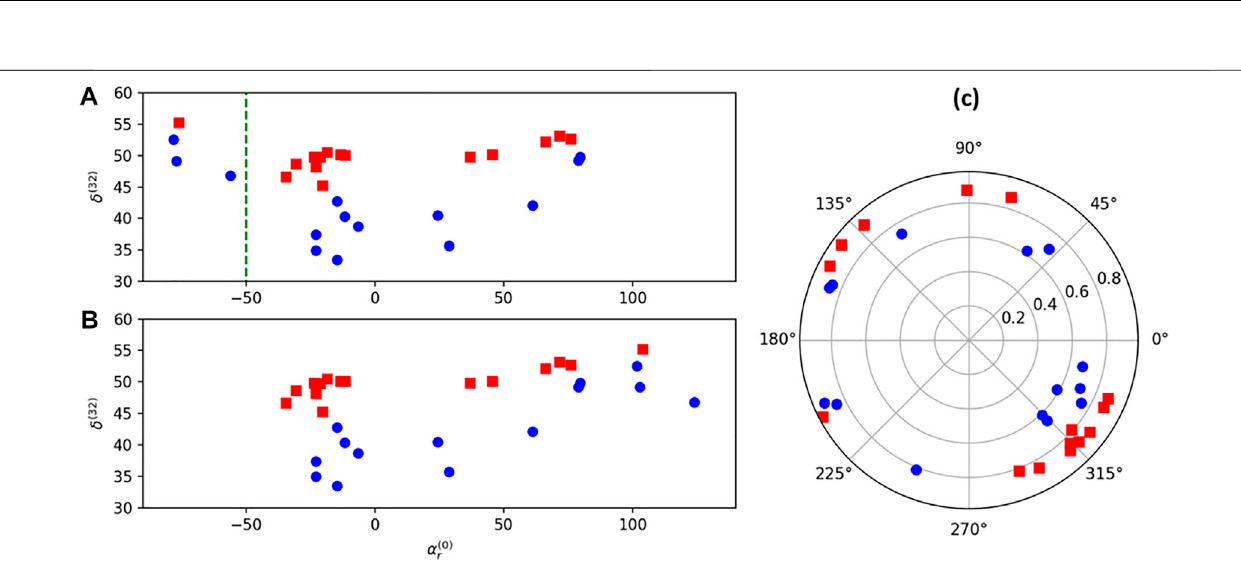
FIGURE 6 | Scatter plot of α ( 0 ) r and δ ( 32 ) at a different orientation angle. (A) shows the original scatter plot without unwrapping, (B) shows the scatter plot after unwrapping,essentiallyshiftingthepointsontheleftofthedottedlinebyoneperiod,and (C) showsthesameplotinpolarcoordinates,wheretheangleofthescatterplot is 2 α ( 0 ) r and the radius is δ ( 32 )